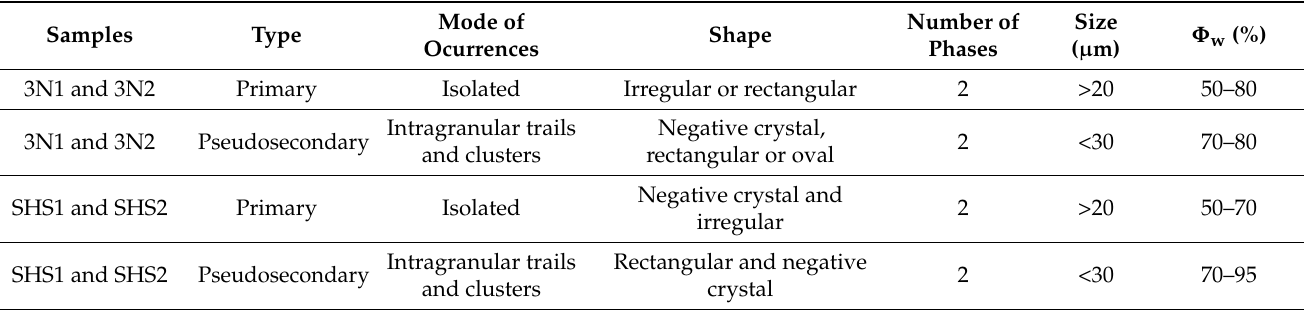
Table 4. The T mice of aqueous-carbonic FIs consisting mainly of CO 2 ranges from − 7.2 ◦ C